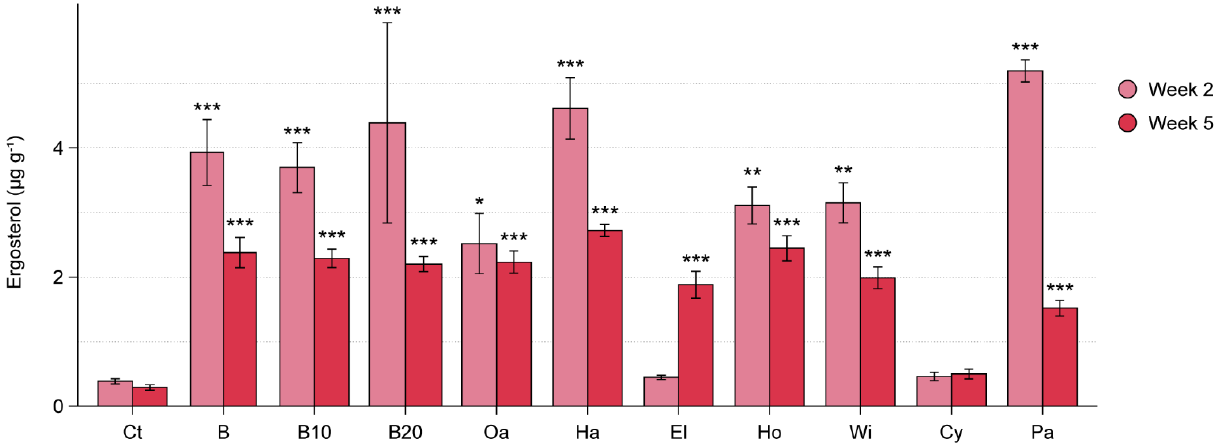
Figure 4. Fungal biomass stimulation in soil amended with sawdust of seven wood types, pre-decomposed beech sawdust, and paper pulp (WT experiment). Soil treatments are indicated as: Ct = control, B = beech sawdust, B10 = 10% pre-decomposed beech, B20 = 20% pre-decomposed beech, Oa = oak, Ha = hazel, El = elder, Ho = holly, Wi = willow, Cy = cypress, Pa = paper pulp. Ergosterol concentration is shown for amended and control pots (mean ± se , n = 5) at the time of beetroot sowing (two weeks after amendment) and at harvesting of beetroot seedlings (five weeks after amendment). Significant differences between each treatment and the control (Dunnett’s test) are indicated as * 0.05 > p > 0.01; ** 0.01 > p > 0.001; *** p < 0.001.